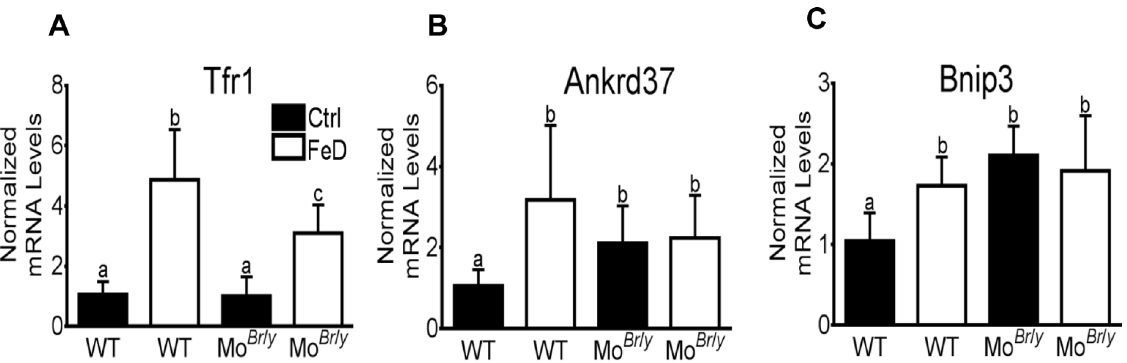
Figure 4. Liver qRT-PCR analysis of iron- and hypoxia-related genes. Expression of key genes (indicated in each panel) was determined by standard methods, with each experimental gene being normalized to expression of mouse cyclophilin mRNA (which did not vary significantly). Filled bars represent data from mice fed the control diet and open bars represent data from mice consuming the low-iron diet. Genotype is indicated below each bar. a,b,c,d Statistically different from one another within each panel ( p , 0.05). n=6 for all groups. WT, wild type; Ankrd37, Ankyrin repeat domain